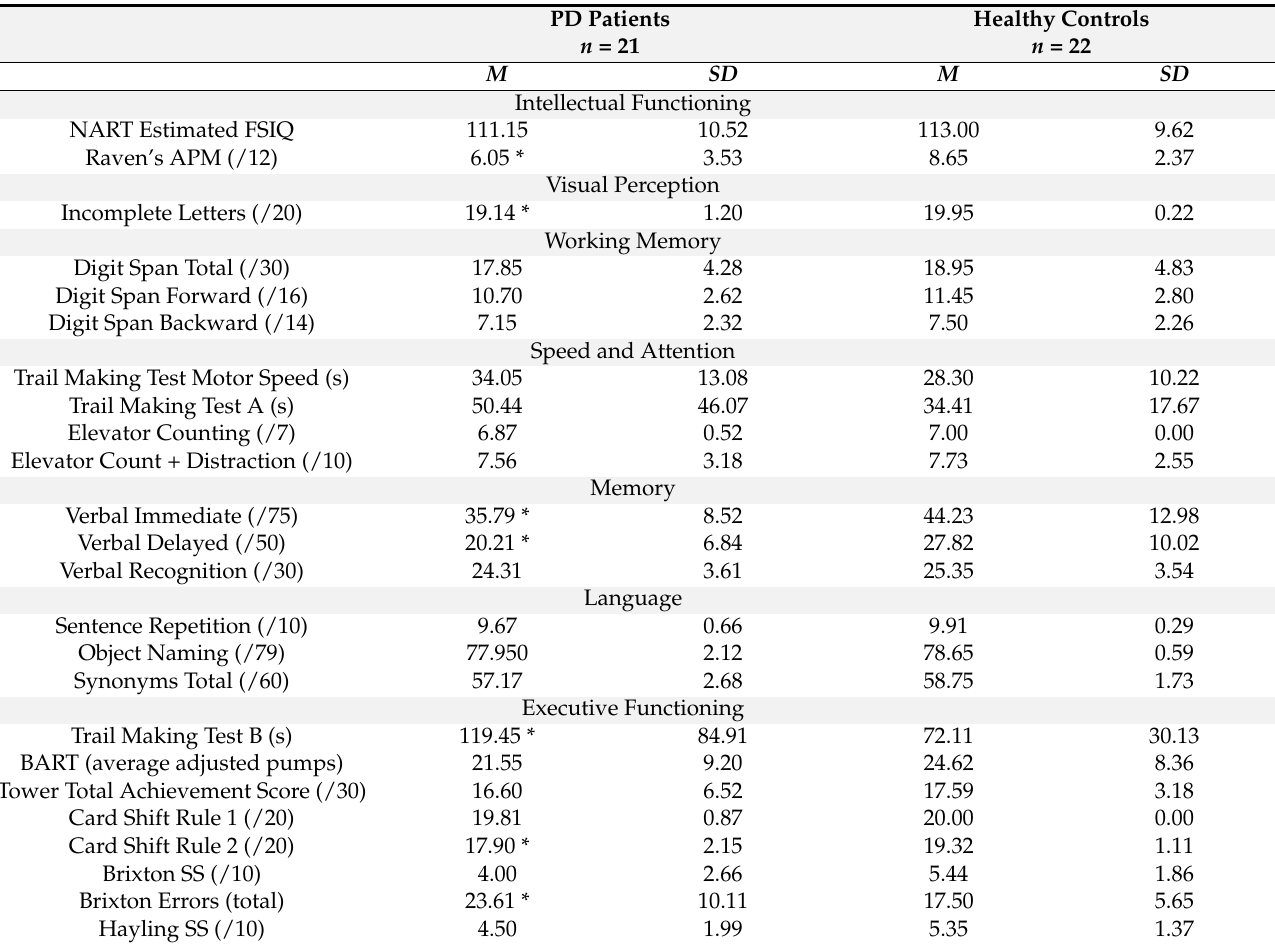
Table 3. Cognitive tests for PD patients and healthy controls.